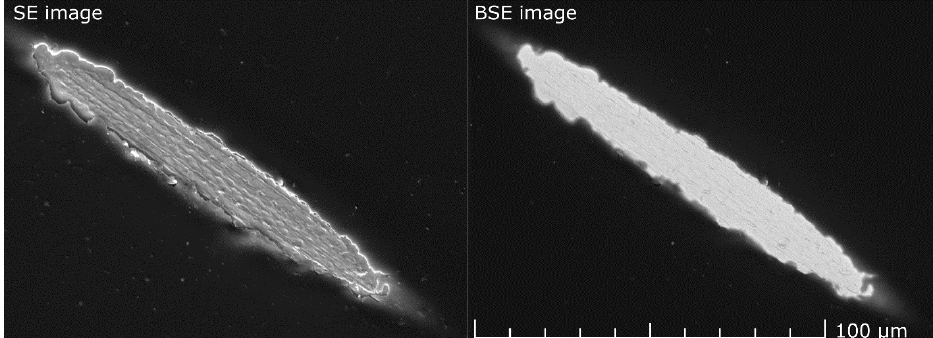
Figure 4. SEM micrograph of the uncovered wire top after 1 s H 2 plasma exposure (distance H = 0.35 mm).